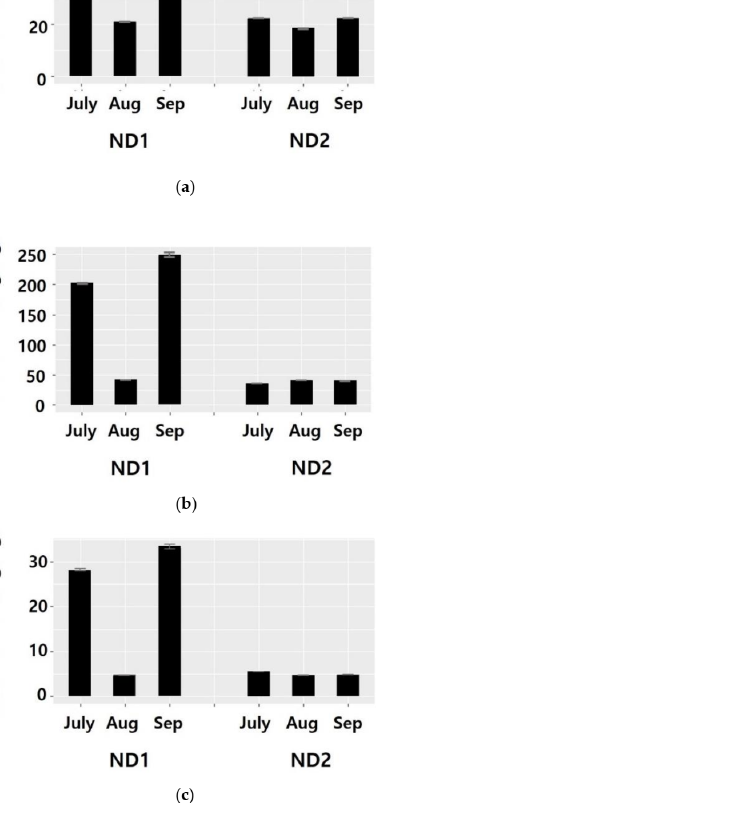
Figure 4. Concentration of ( a ) Cu, ( b ) Zn, and ( c ) Pb in sediment samples from the HCW, analyzed by aqua regia